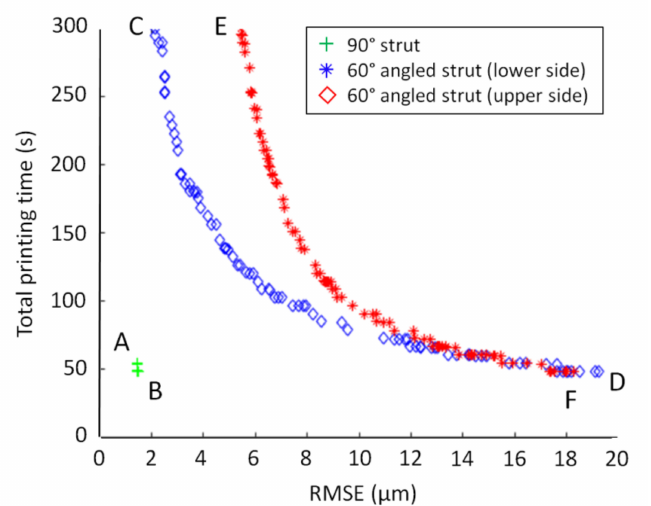
Figure 10. Pareto optimal sets for a vertical strut (green), optimizing upper side of 60 ◦ angled strut (red) in Figure 11, and optimizing lower side of 60 ◦ angled strut (blue) in Figure 11. Point C and D are two extremes of optimizing lower side of the 60 ◦ angled strut. Point E and F are two extremes of optimizing upper side of the 60 ◦ angled